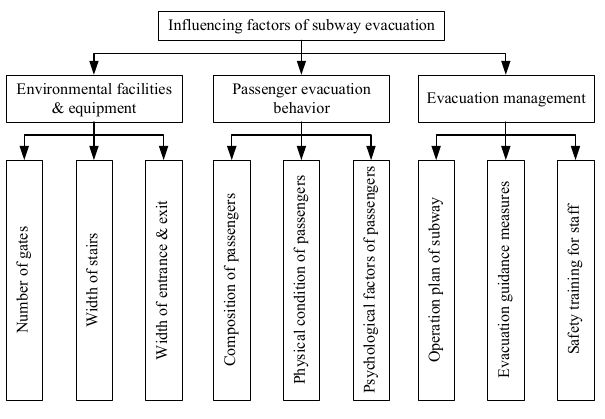
Figure 3. Index system of influencing factors for subway evacuation.